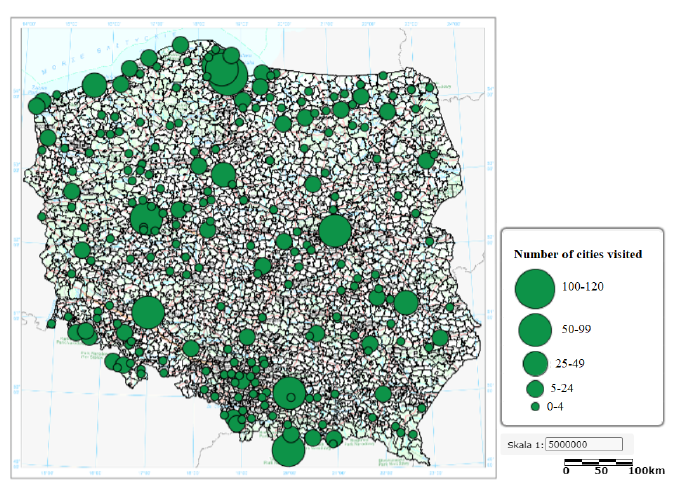
Figure 1: Number of tourists surveyed by urban destination in